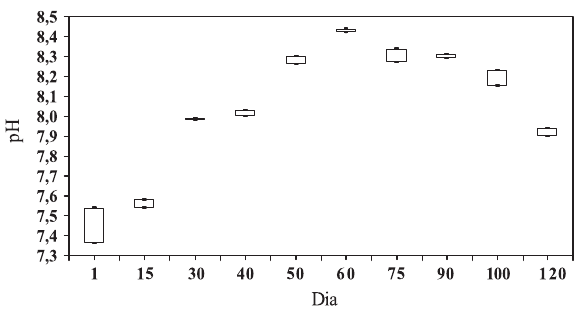
figura 2. evolução do pH do solo durante a bior- remediação. Box plot: valores de pH mínimo e pH máximo das determinações em triplicatas.